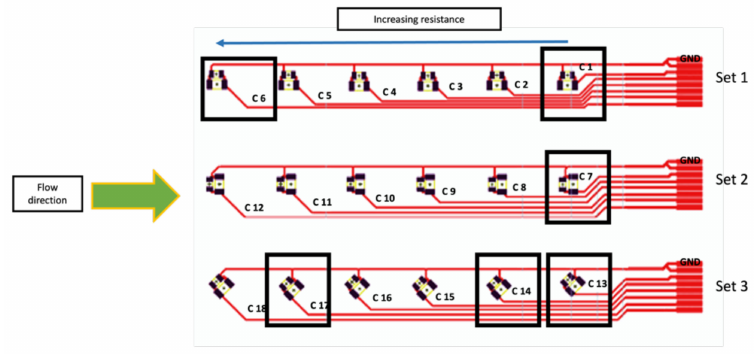
Figure 27. Typical failure locations for the corner mold.